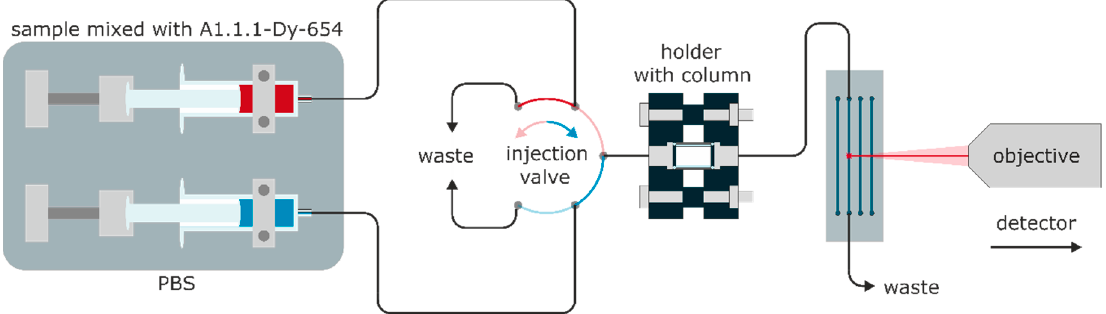
Figure 3. Microfluidic setup for the detection of TNT and the cross-reactivity (CR) determination with six-way-valve for continuous flow injection.